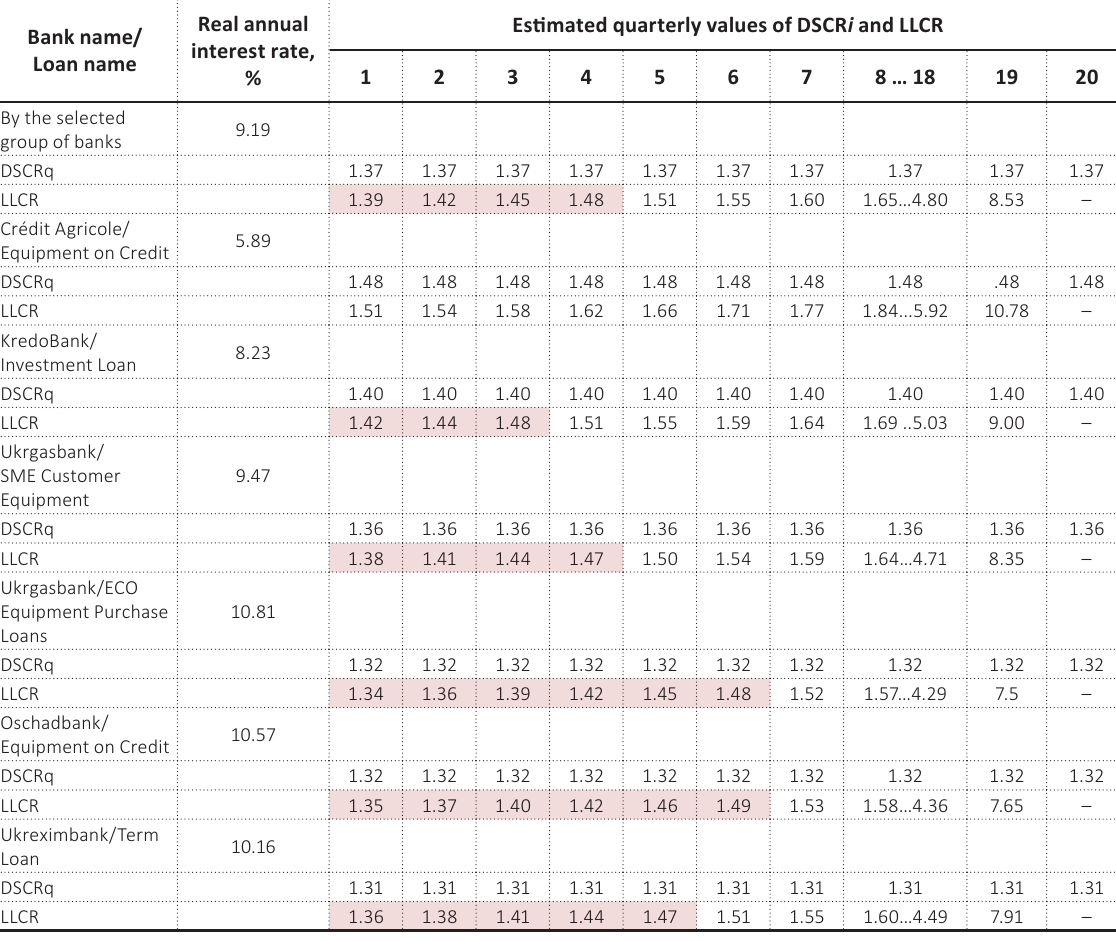
Table 2. Test results for banking institutions’ compliance with covenant terms for 5-year lending to an investment project in Ukraine